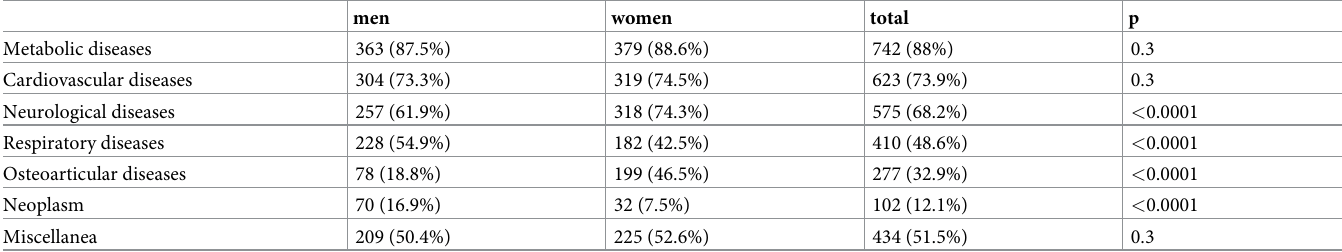
Table 2. Gender patterns of